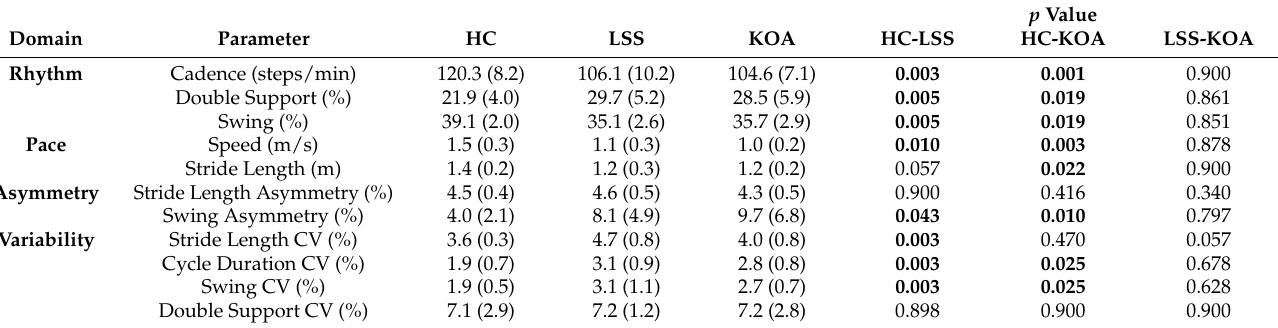
Table 2. Gait parameters extracted from the analysis of the entire